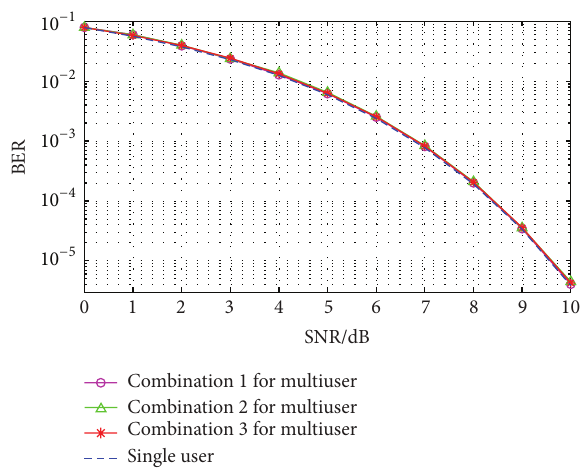
Figure 7: Performance of each combination mode in a synchronous system.